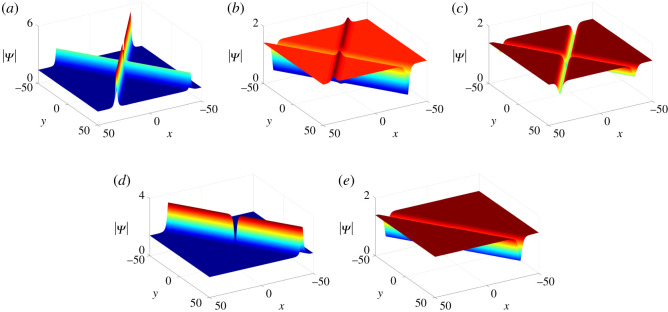
Two-soliton solutions of equation (1.3) at t = 0 with parameter values κ = 1, ξ10 = 0, ρ = 1/2, μ = 10 and (a) ν = 5, θ = 3π/4, (b) ν = 20, θ = π/4, (c) ν = 0, θ = π/4; degenerate solitons: (d) ν = −10, θ = 3π/4, (e) ν = 10, θ = π/4.